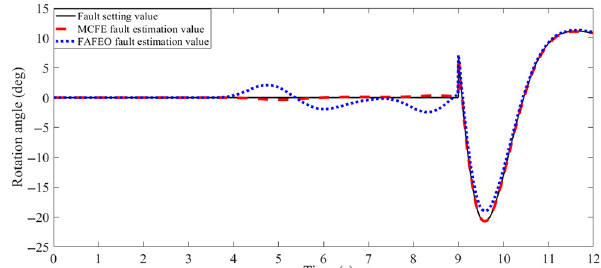
Figure 16 Fault estimation curve of the rotation angle